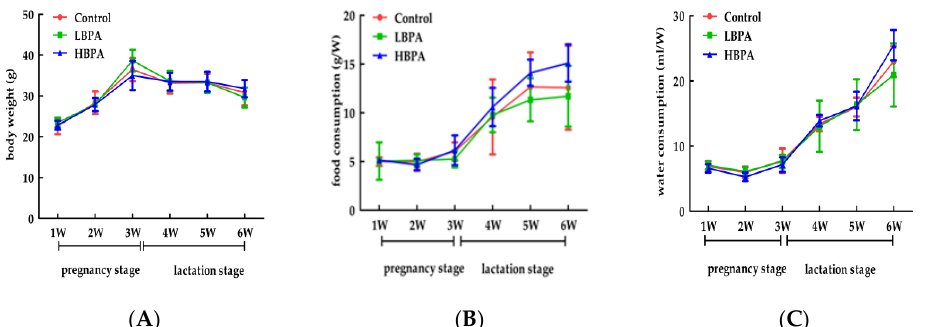
Figure 1. The effects of perinatal bisphenol A (BPA) exposure on maternal body weight, food intake, and water consumption. Pregnant mice ( n = 7/group) were exposed to ethanol or BPA in water at levels of 0.2 μg/mL (LBPA) or 2 μg/mL (HBPA) from gestational day 6 through to the end of lactation. Changes in mean body weight ( A ), amount of food intake ( B ), and water intake ( C ) were measured during pregnancy. Values represent the mean ± standard error (SE) and were analyzed by one-way analysis of variance (ANOVA).